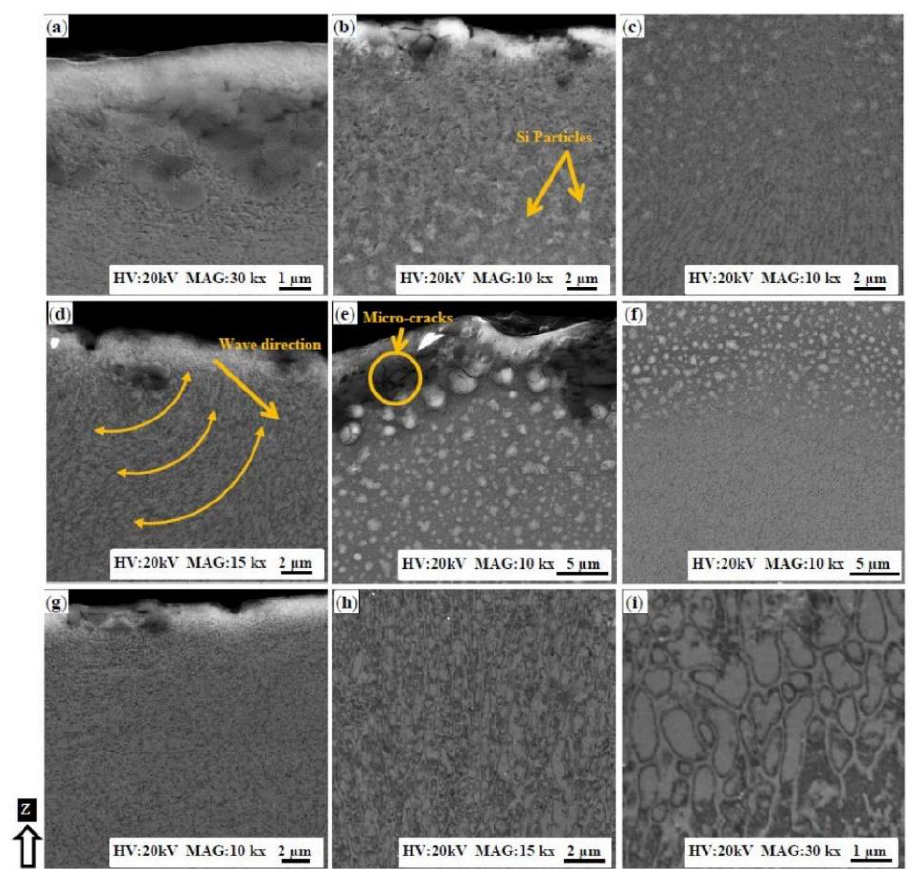
Figure 12. Microstructure development due to LSP of AlSi10Mg samples under various resolution: ( a – c ) as-built + LSP; ( d – f ) machined surface + High-LSP, and ( g – i ) machined surface + LSP [69]; published under MDPI open-access license.